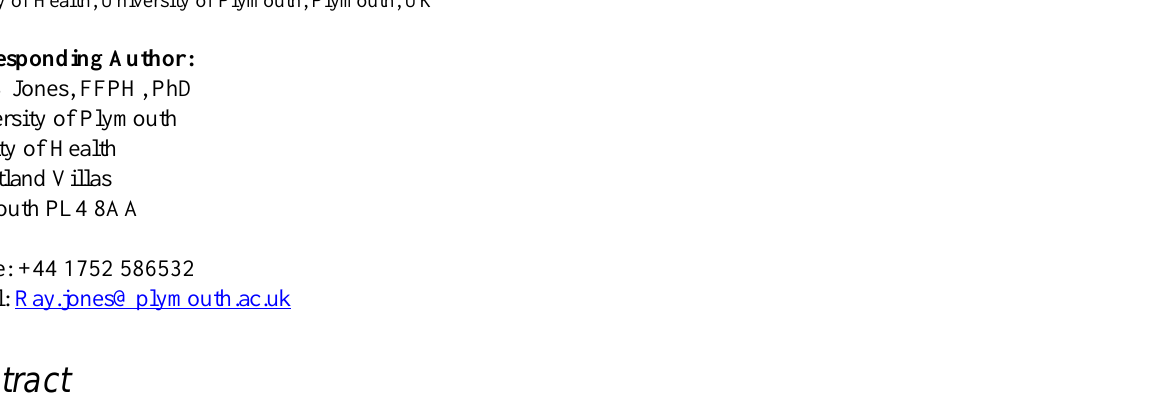
Webcasting; synchronous e-learning;